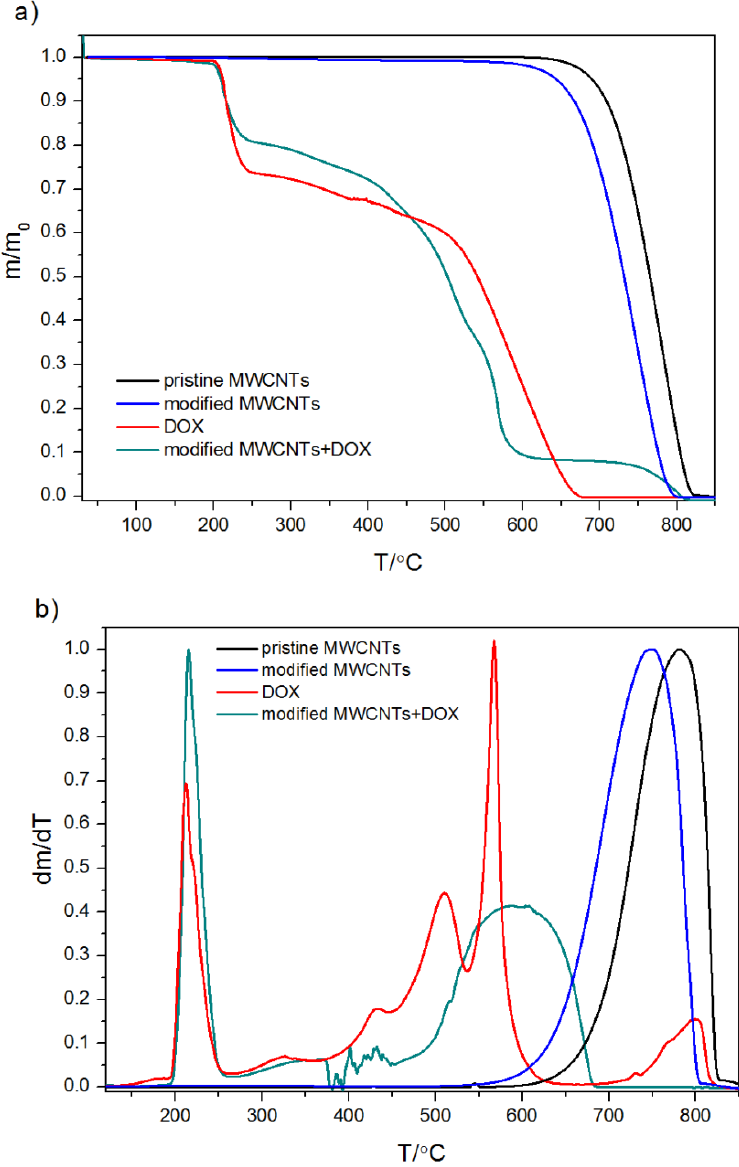
Figure 3. TGA curves determined under oxidizing atmosphere ( a ) and their first derivative ( b ).